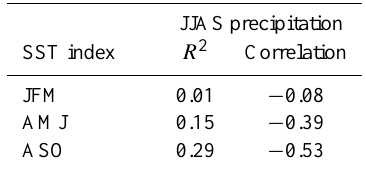
Table 1. The coefficient of determination and correlation for the linear fit between Niño 3.4 index in different seasons and the JJAS discharge anomalies at Eldiem station for the period 1965–2012.